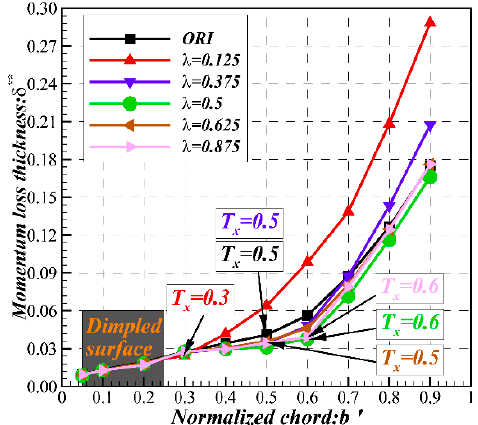
Figure 16. Development of the momentum thickness of boundary layer.